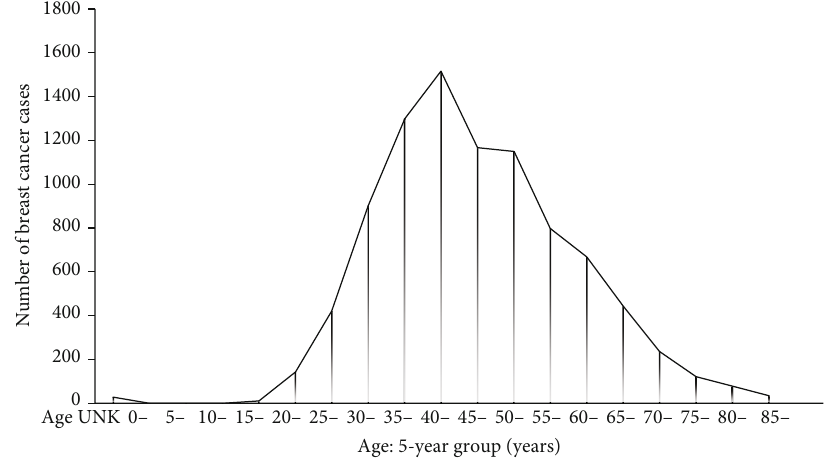
Figure 2: Age distribution of breast cancer in females across various age groups in 15 centers in